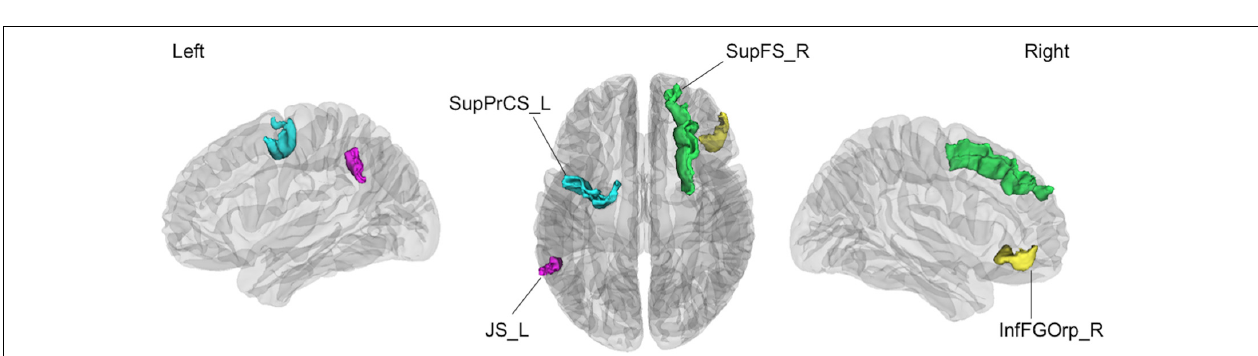
FIGURE 2 | Contributions of clinical data and gray matter volume data to the classification of safe and unsafe drivers in the final model. The number of times each parameter was selected in the cross-validation is shown for all 36 parameters. Higher numbers represent a greater contribution to the classifier. Five parameters (age and gray matter volume of four cortical regions, including the left superior part of the precentral sulcus, the left sulcus intermedius primus [of Jensen], the right orbital part of the inferior frontal gyrus, and the right superior frontal sulcus) were consistently selected at every iteration. JS_L, the left sulcus intermedius primus (of Jensen); SupPrCS_L, the left superior part of the precentral sulcus; InfFGOrp_R, the right orbital part of the inferior frontal gyrus; SupFS_R, the right superior frontal sulcus; RTI, reaction time; SupOcG_L, the left superior occipital gyrus; RAVLT 1, the first trial of the Rey Auditory Verbal Learning Test immediate recall; EMC, Everyday Memory Checklist; SupTGLp_L, the left lateral aspect of the superior temporal gyrus; PosVCgG_R, the right posterior-ventral part of the cingulate gyrus; MFG_R, the right middle frontal gyrus; PAL TE, paired associates learning total error; ROCFT delay, Delayed recall of the Rey–Osterrieth Complex Figure Test; InfFGTrip_L, the left triangular part of the inferior frontal gyrus; InfOcG/S_R, the right inferior occipital gyrus and sulcus; ATrCoS_L, the left anterior transverse collateral sulcus; MOT, motor screening task; RAVLT delay, Delayed recall in the Rey Auditory Verbal Learning Test; IntPS/TrPS_R, the right intraparietal sulcus (interparietal sulcus) and transverse parietal sulci; ST III, Time taken to finish the Stroop Test part III; RCPM, Raven’s Colored Progressive Matrices; ATrCoS_R, the right anterior transverse collateral sulcus; MaxVA, Maximal functional visual acuity; TPl_L, the left temporal plane of the superior temporal gyrus; InfFGTrip_R, the right triangular part of the inferior frontal gyrus; LoInG/CInS_R, the right long insular gyrus and central insular sulcus; SupOcS/TrOcS_L, the left superior occipital sulcus and transverse occipital sulcus; SbPS_R, the right subparietal sulcus; PosDCgG_L, the left posterior-dorsal part of the cingulate gyrus; MFG_L, the left middle frontal gyrus; InfTS_L, the left inferior temporal sulcus; SbCG/S_R, the right subcentral gyrus (central operculum) and sulci.